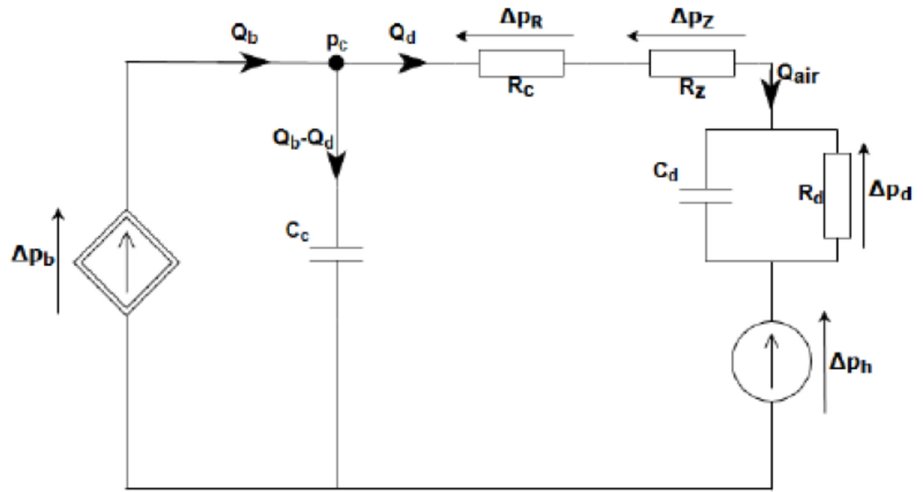
Figure 5. The electrical analogy of the aeration system model.